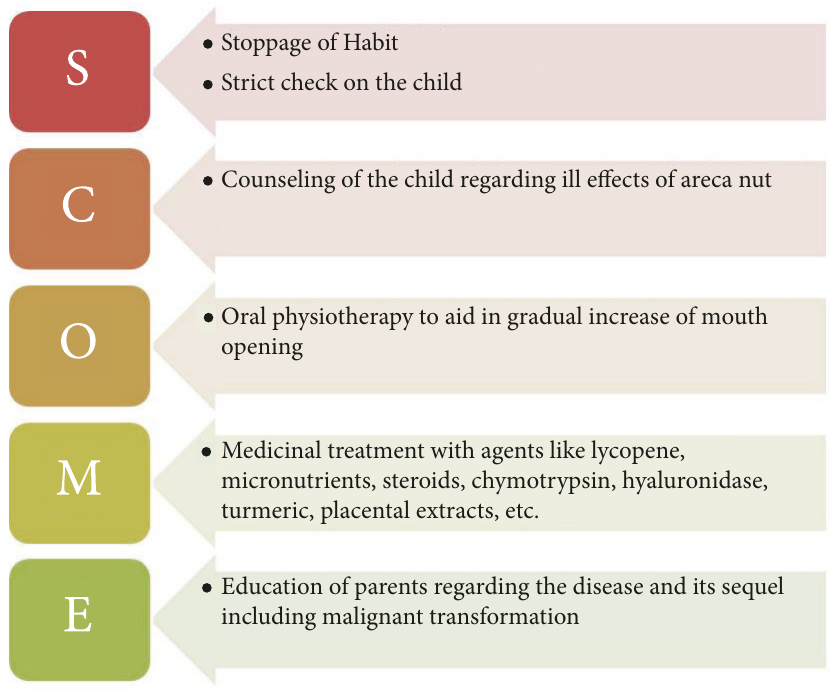
Figure 2: Protocol for management of Oral Submucous Fibrosis in Pediatric